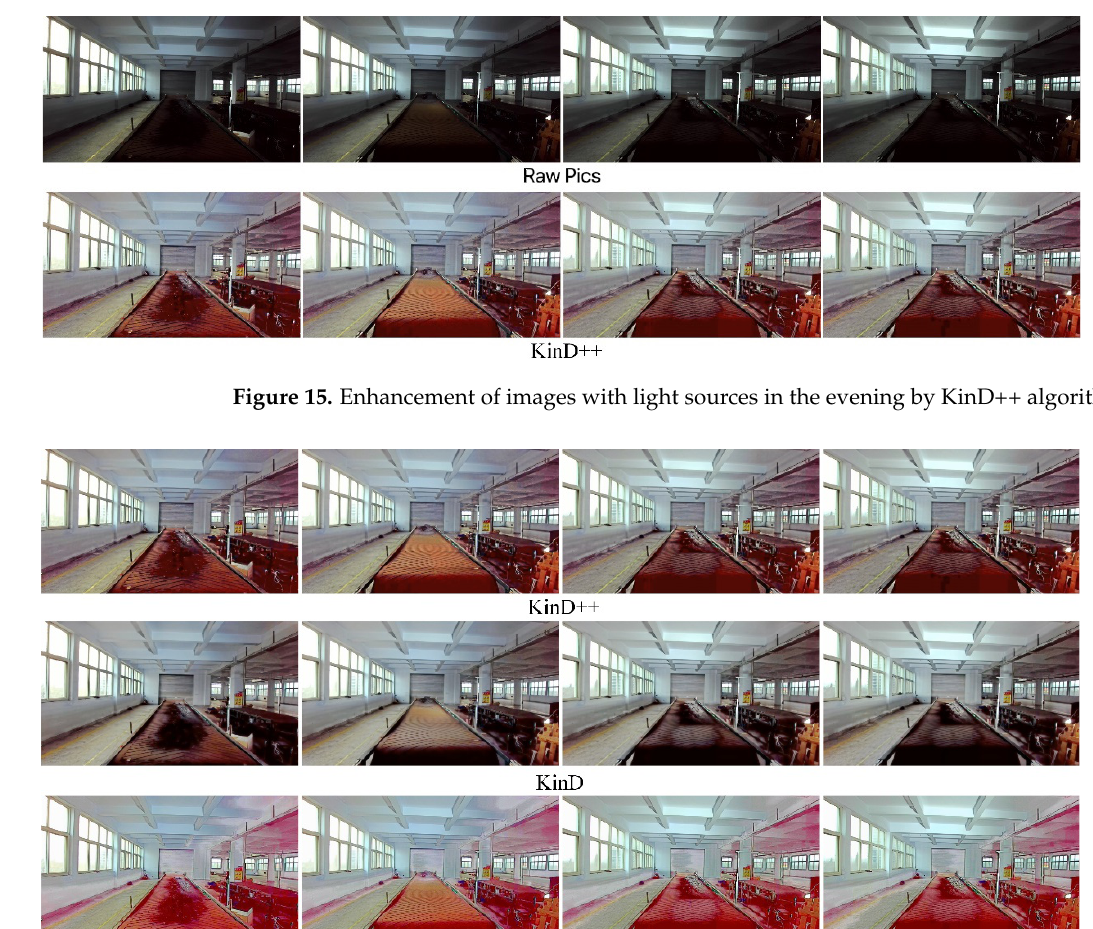
Figure 17. Enhancement of images with light sources in the evening by traditional algorithms.